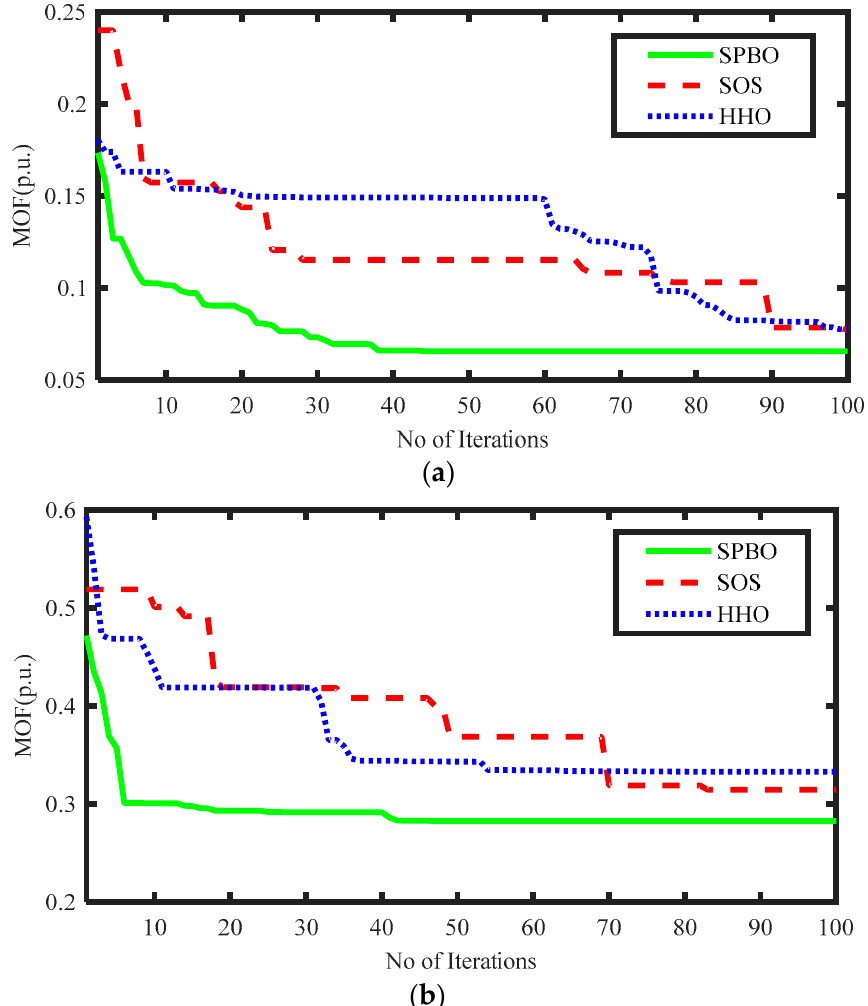
Figure 6. CC of optimization algorithms for case-5. ( a ) 33-bus test system; ( b ) 118-bus test system. The results of simultaneous allocation of D-STATCOMs and GT-DGs using SPBO, SOS, and HHO algorithms are presented in Tables 11 and 12 for both the test systems. The optimal effective sizes of the D-STATCOMs and GT-DGs are (1.9081 MVAr, 2.9477 MW), (1.8138 MVAr, 3.3573 MW), and (1.3148 MVAr, 3.1555 MW) for the 33-node test system as 24 Table 12. Comparison of results for simultaneous DS and GT-DG allocation (case-6) for 118-bus test system. Method